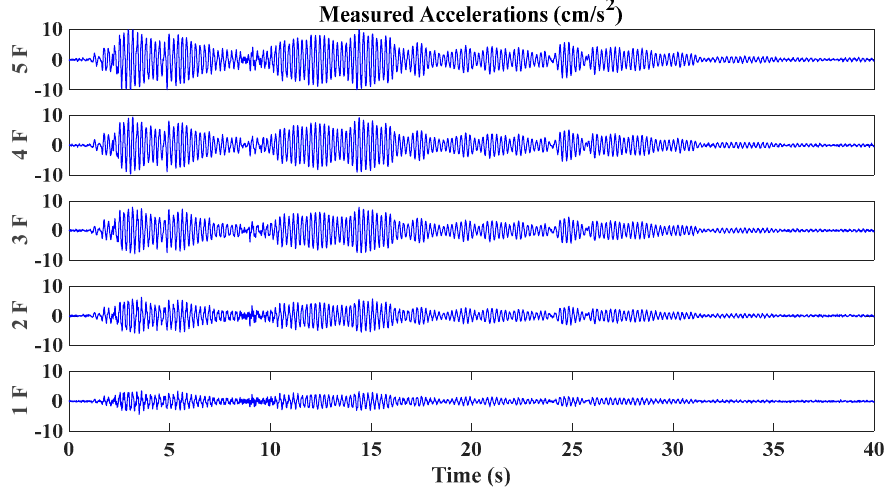
Figure 4. Time histories of simulated acceleration excited by mutually correlated white noises.